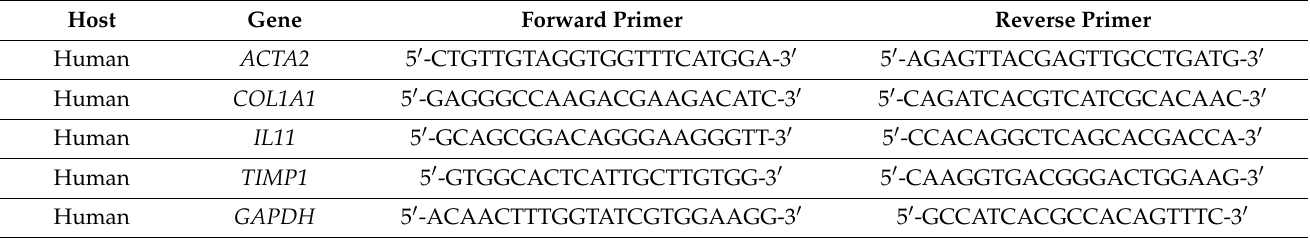
Table 2. Primer sequences for